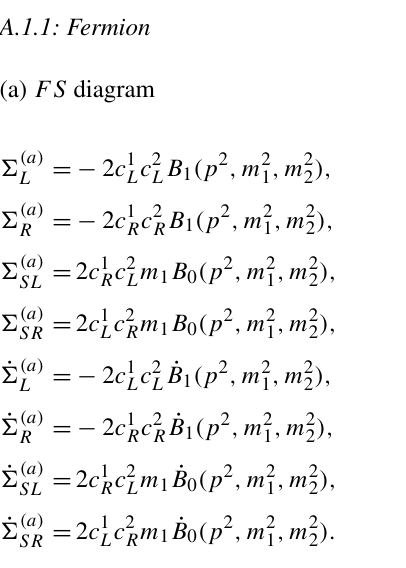
Fig. 18 Generic diagrams contributing to S → SS